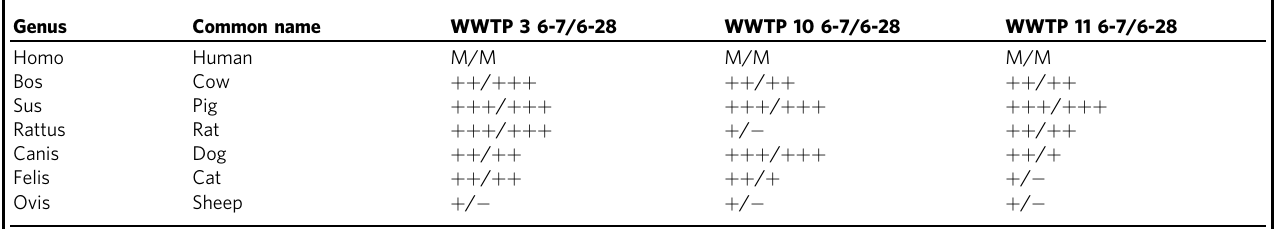
Table 1 Predominant species detected in NYC wastewater via deep sequencing of 12S